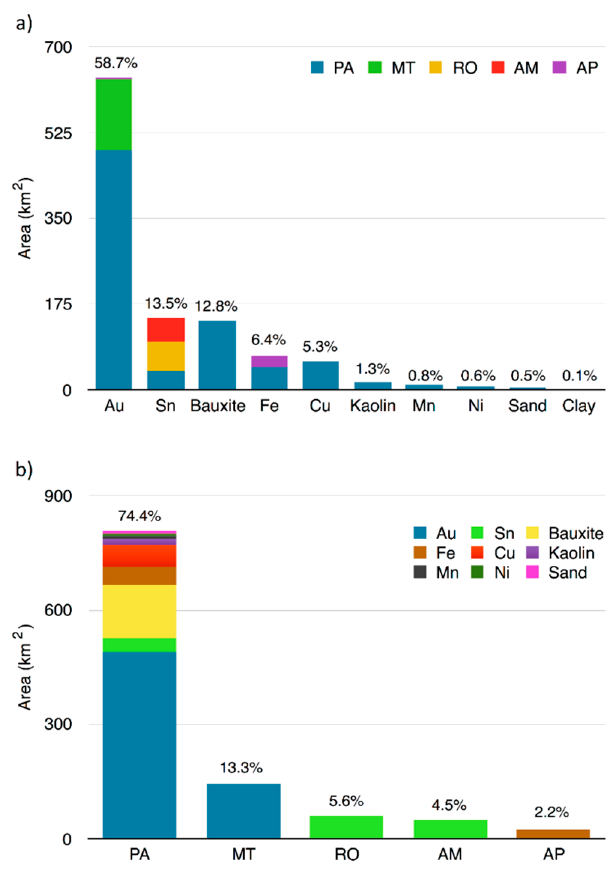
Figure 5. Distribution of mining area (km 2 ) based on mineral types ( a ): Au—Gold; Fe—Iron; Mn—Manganese; Sn—Tin; Cu—Copper; Ni—Nickel; and Federal Units ( b ): AM—Amazonas, AP—Amapá, MT—Mato Grosso, PA—Pará, RO—Rondônia.